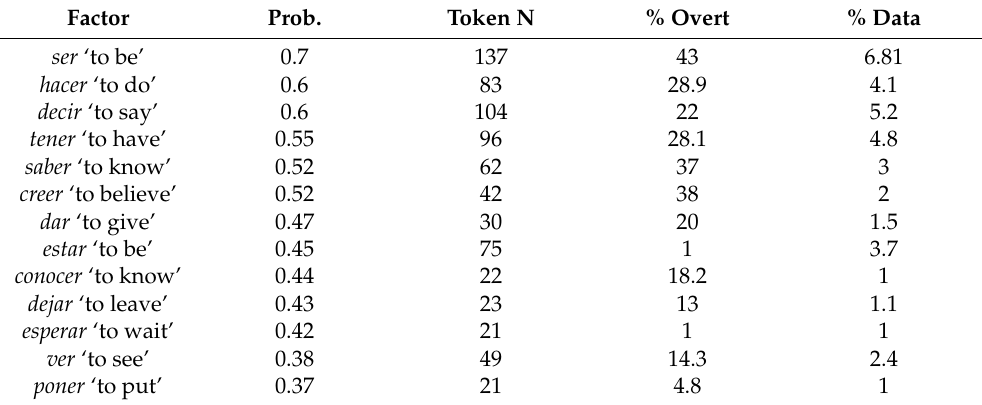
Table 5. Lexical frequency effect of the verb on overt SPPs.